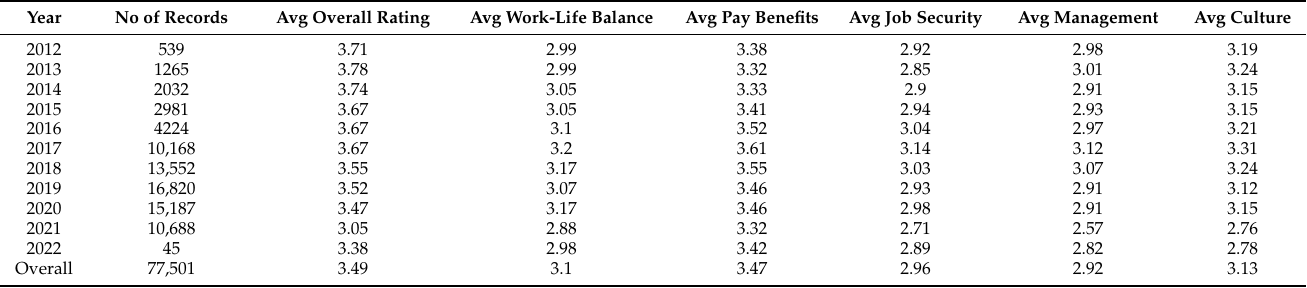
Table 3. Averages of the important variables obtained from collected